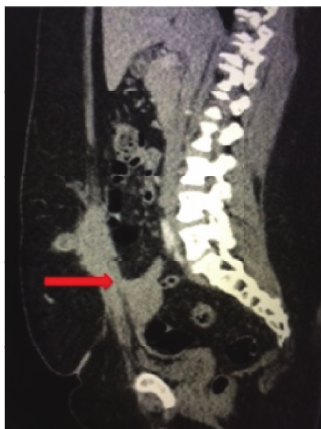
Figure 2: Cross-sectional imaging demonstrating invasion of the abdominal wall mass into the uterus (arrow).